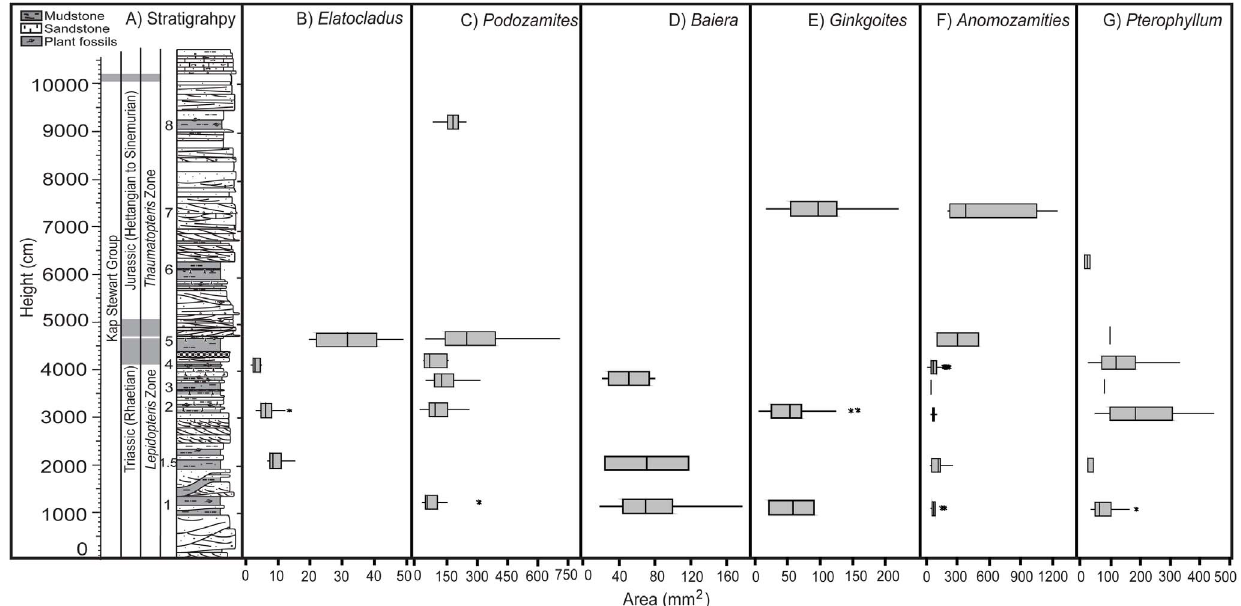
Figure 3. Astartekløft stratigraphic log (A) (after [ 5;25 ] ) compared to area changes showed as box plots in the measured fossil taxa: Elatocladus (B); Podozamites (C); Baiera (D); Ginkgoites (E); Anomozamites (F); Pterophyllum